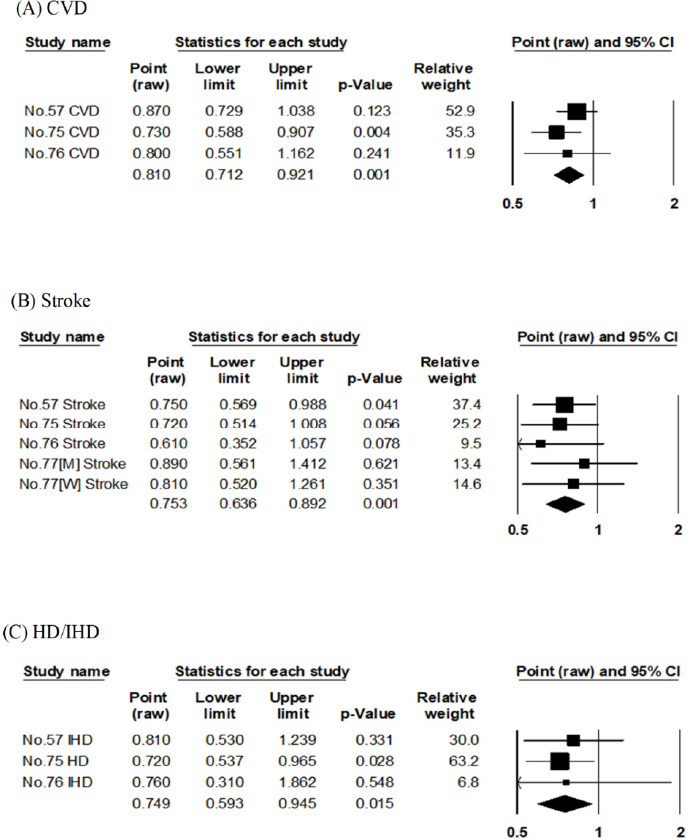
Figure 8. Meta-analysis of plant-derived protein consumption and mortality risk. ( A – C ) show the association between plant-derived protein consumption and CVD, stroke, and HD/IHD mortality risk, respectively. The area of each square is proportional to the study weight. Horizontal lines represent 95% confidence intervals. Diamonds represent pooled estimates from inverse-variance- weighted random-effects model. The number given in the study name indicates that of the cited reference [55,75–77]. CVD; cardiovascular disease, HD; heart disease, IHD; ischemic heart disease. Carbohydrate Four articles evaluated the association between CVD mortality and intake of carbo- hydrates other than dietary fiber [64,79–81] (Table S3). Of the three articles on the Taka- yama Study, two evaluated the association with the risk of CVD mortality [79,80], and one evaluated the risk of stroke mortality [64]. In men, higher starch consumption reduced the risk of CVD mortality (0.62, 95% CI: 0.45–0.86, p for trend = 0.008), whereas higher con- sumption of saccharides (monosaccharides and disaccharides) increased that risk [79] (1.39, 95% CI: 1.08–1.78, p for trend = 0.001). In women, consuming a diet with a higher glycemic index increased the mortality risk of CVD (1.56, 95% CI: 1.15–2.13, p for trend = 0.007) [80] and stroke (2.09, 95% CI: 1.01–4.31, p for trend = 0.10) [64]. However, another cohort study on NIPPON DATA 80 reported no association between starch consumption